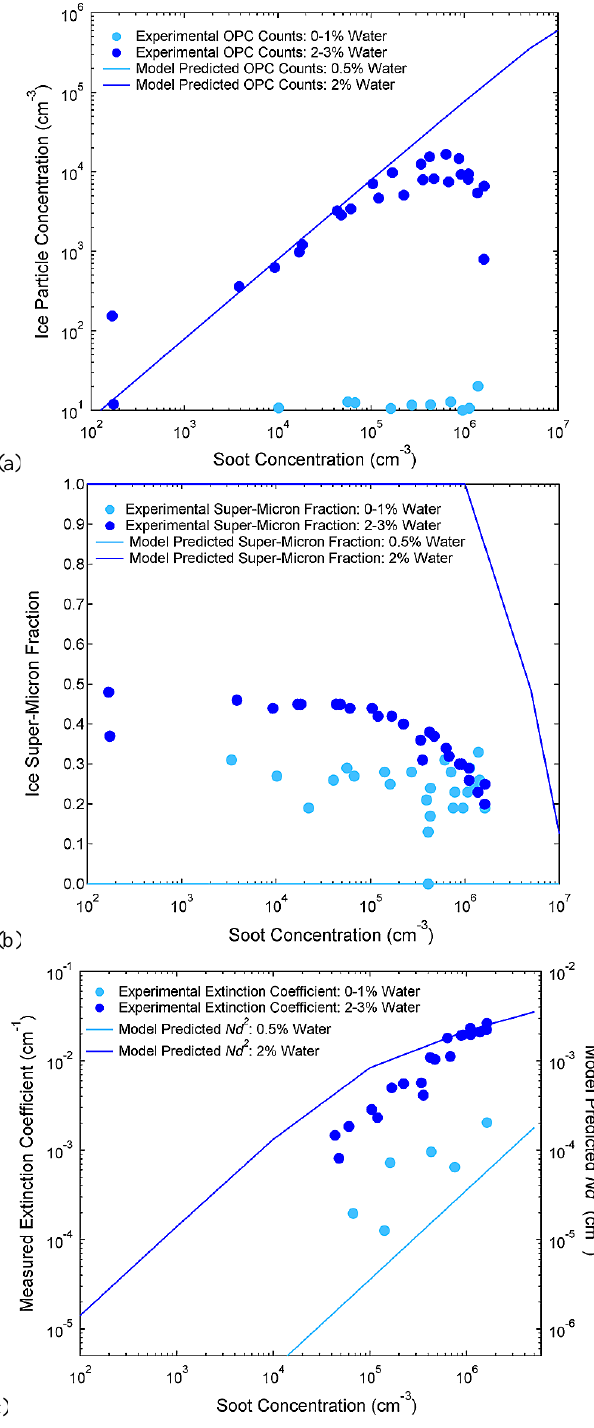
Fig. 6. Comparison of (a) model predicted and measured ice particle concentration from the OPCs (note that at 0.5% molar fraction of exhaust water level, the model predicted no ice particle formation), (b) model predicted and measured ice particle super-micron frac- tion, and (c) measured ice particle extinction coefficients and model predicted ice particle concentration ( N ) multiplied by particle di- ameter squared ( d 2 ). The measurements were performed at 61cm downstream of the nozzle under 30000ft standard day conditions.